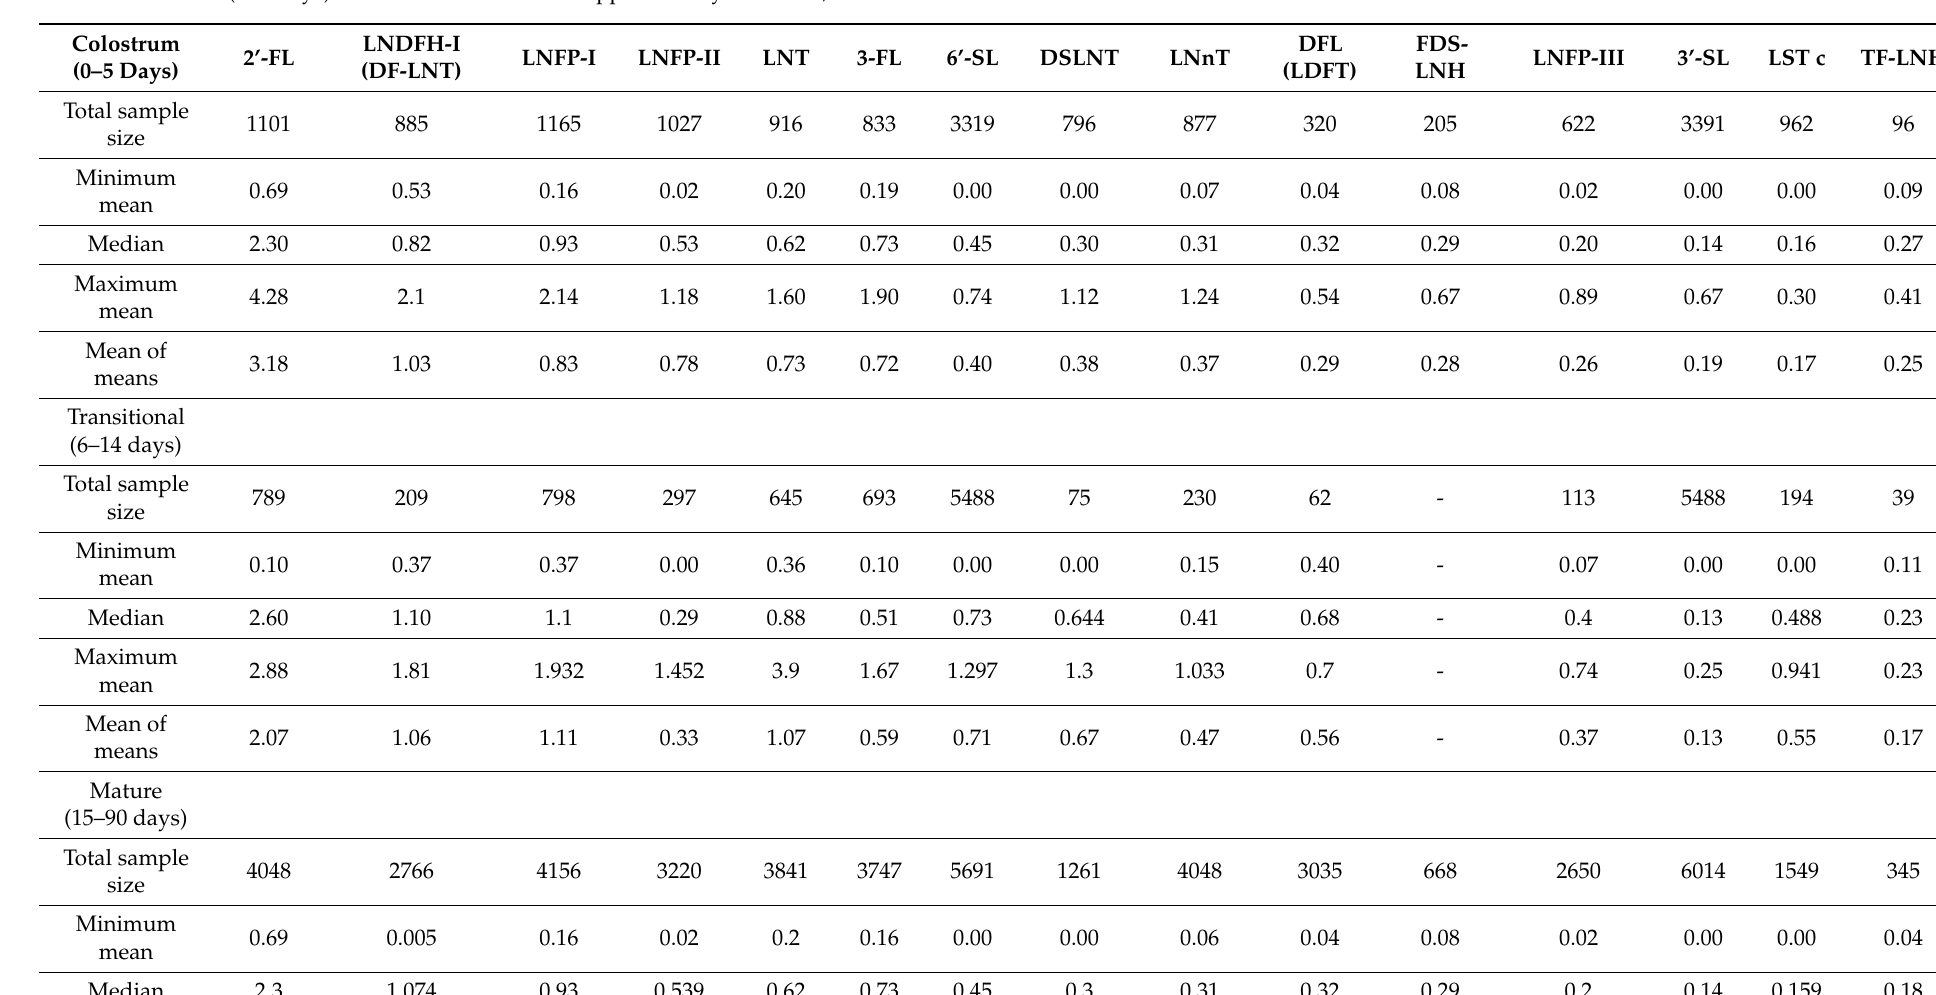
Table 6. Descriptive statistics (g/L) of the most abundant HMOs by lactation stage in pooled globalised milk: colostrum (0–5 days), transitional milk (6–14 days), mature milk (15–90 days) and late milk (>90 days). More data available in Supplementary Materials, Table